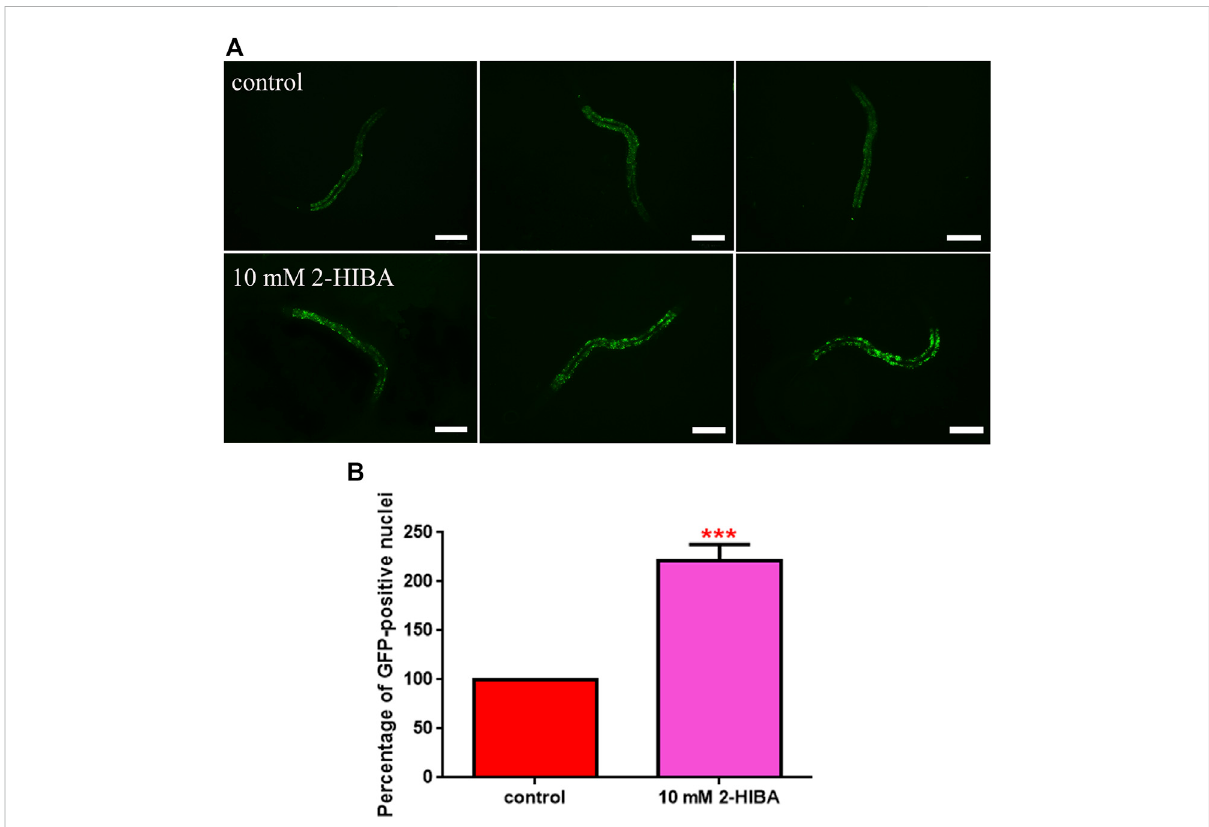
FIGURE 6 Fluorescence analysis of skn-1 ::GFP transgenic strain. (A) Effect of 10 mM 2-HIBA treatment on localization of SKN-1 transcriptional factor and (B) respective Mean Fluorescence Intensity evaluation. Scale bar = 100 μ m. Data were obtained from three independent experiments (60 worms for each condition). control: untreated worms. Statistical analysis was performed by one-way ANOVA with the Bonferroni post-test; asterisks indicate signi fi cant differences (*** p < 0.001). Bars represent the mean of three independent